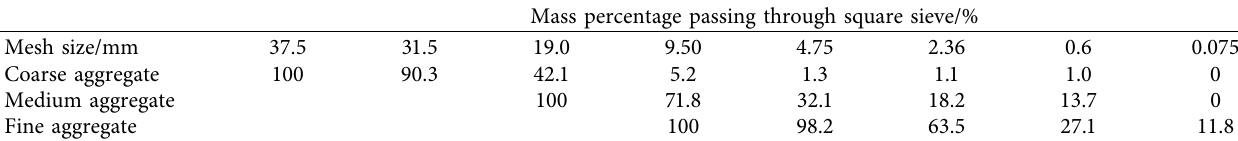
Table 2: Gradation of three aggregates.